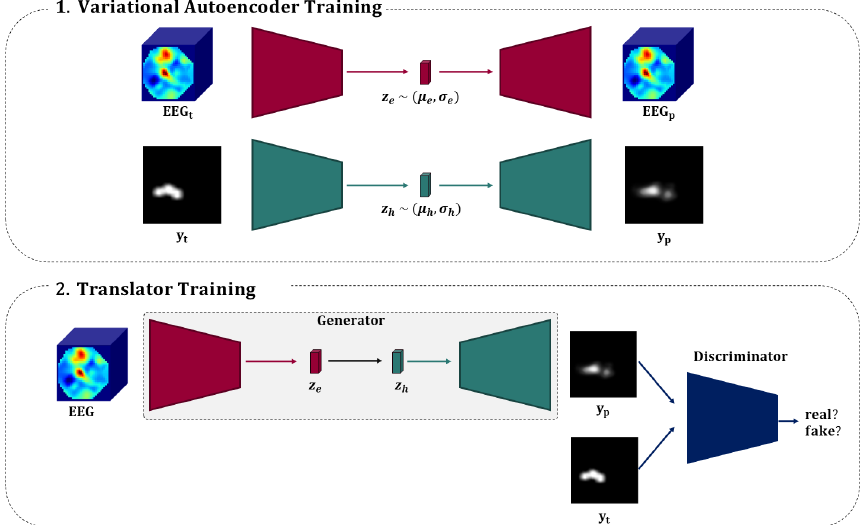
Figure 1. Overview of the proposed framework with the two training procedures. (1). Training of both VAE aiming to encode: EEG signals EEG in the corresponding latent space mean µ e and standard deviation σ e by reconstructing the original signal EEG p from its original representation EEG t ; visual saliency maps y in the corresponding latent space mean µ h and standard deviation σ h by reconstructing the original map y p from its original representation y t . (2). Training of the translator that aims to connect both latent spaces by combining the two pre-trained parts of the VAE. A discriminator distinguishing real map y t to that generated by the generator y p is added to help the generator to create saliency maps similar to the ones in the